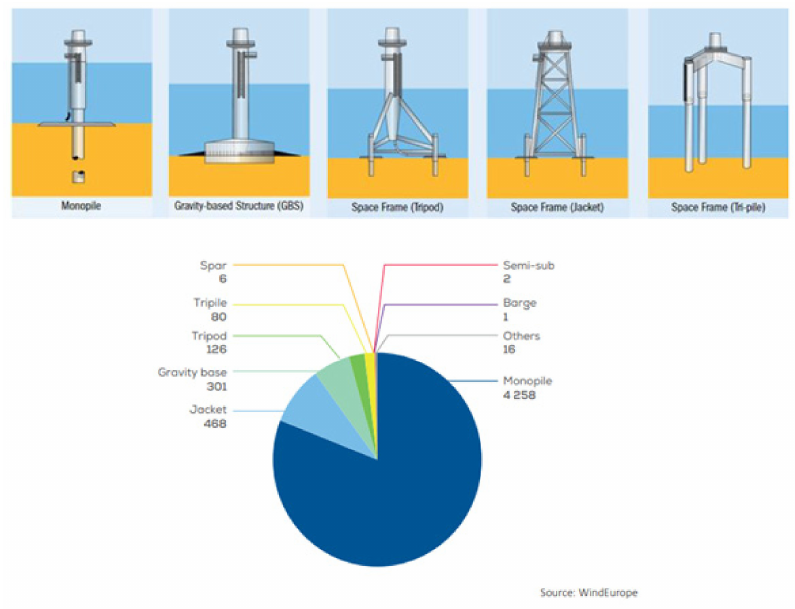
Figure 1. Typical fixed offshore wind farm foundations and comparison of the share in 2018. Source: Wind Europe.